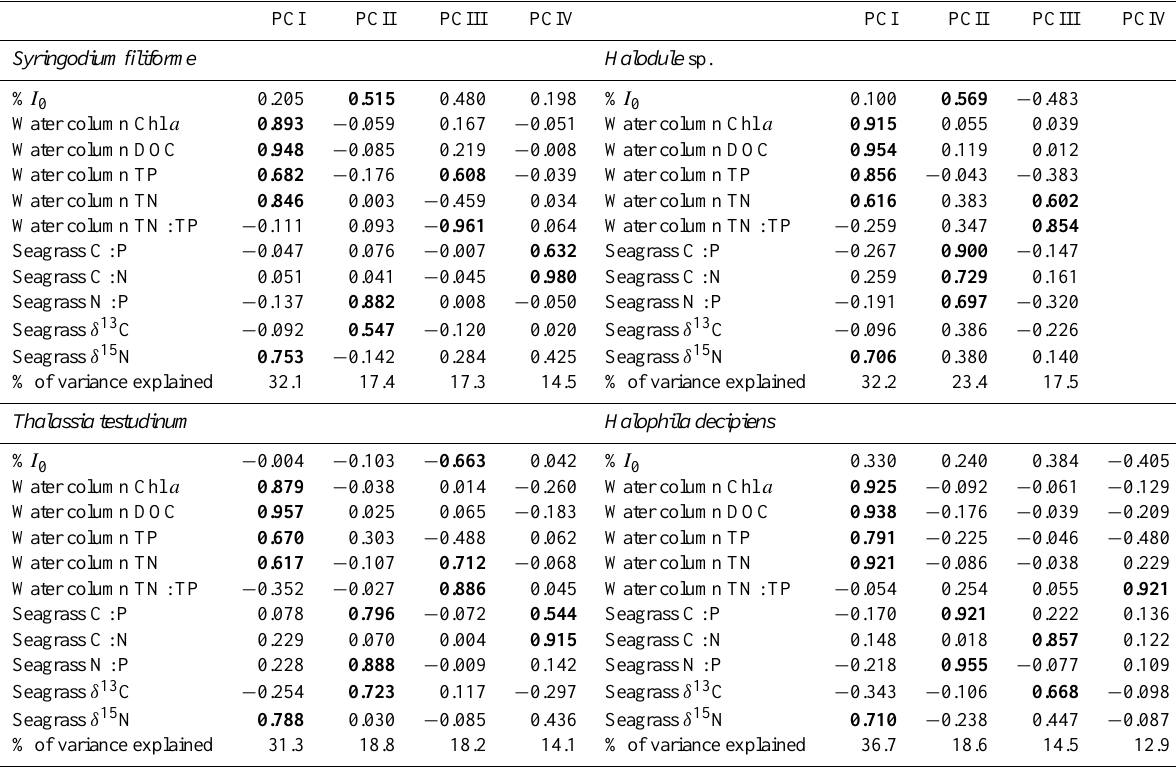
Table 4. Principal component analysis of the relationship among water quality and seagrass environmental and isotopic composition, by seagrass species. Values are the correlations between the original variables and the extracted principal components. Values in bold type have the largest loadings within a principal